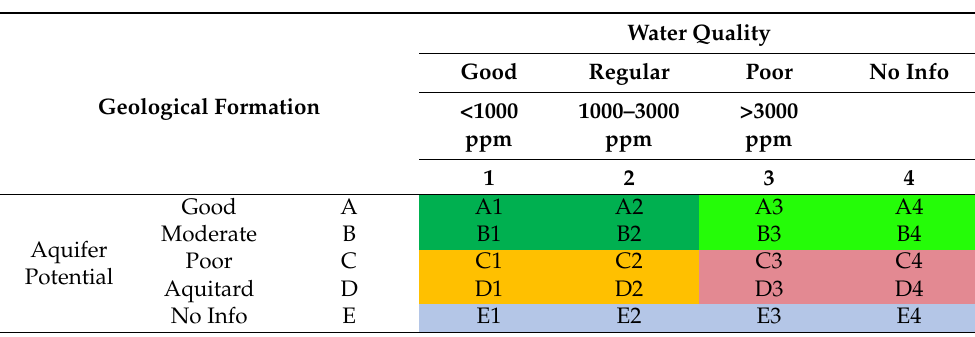
Table 1. Geological formations classified into five groups according to aquifer potential (Good, Moderate, Poor) and water quality (Good, Regular, Poor). The unit of water quality is Total Dissolved Solids (TDS). The colors represent an ID later used in the classification of the units and on the maps. (Adapted from Sanchez et al. [2].)